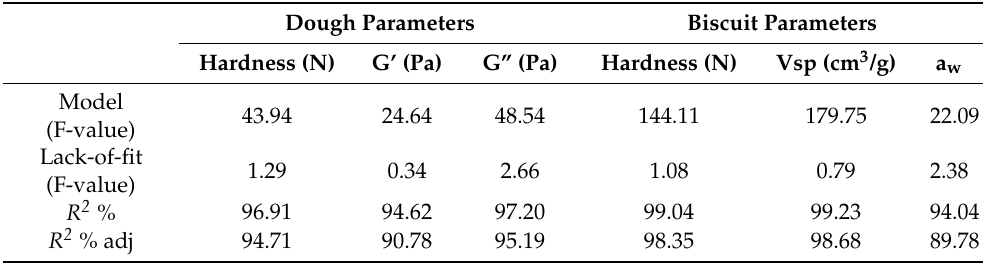
Table 3. Analysis of variance (ANOVA) of the second order polynomial models for different proper- ties of gluten-free doughs and biscuits containing xanthan gum (XG) and locust bean gum (LBG). Dough Parameters Biscuit Parameters Hardness (N)